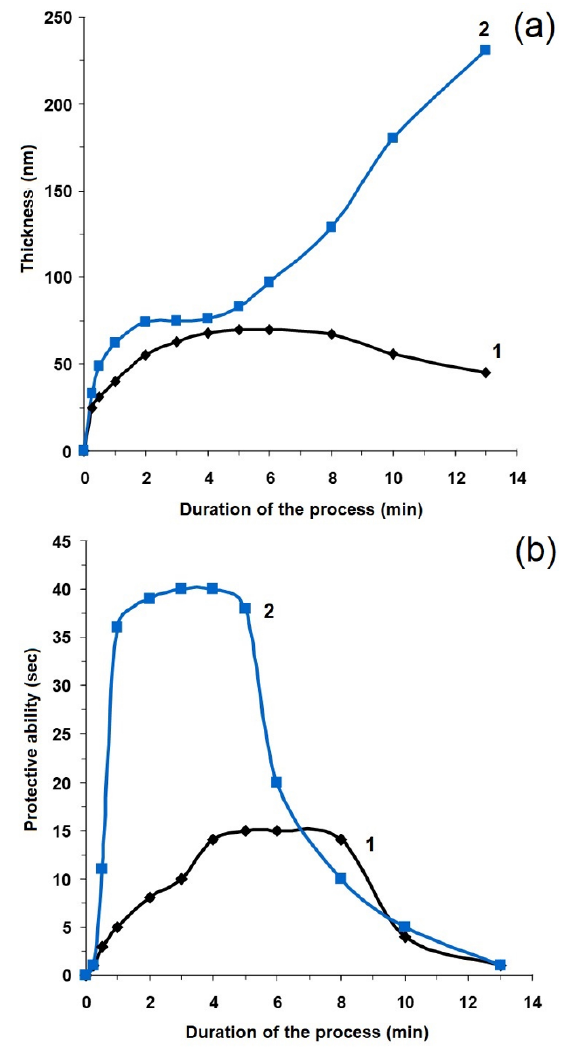
Figure 8. The dependence of the thickness ( a ) and the protective ability ( b ) of coatings on the duration of the process (1. H 2 TiF 6 : 2 g / L; Ni(NO 3 ) 2 : 0.4 g / L; pH 4.6–5.0; T : 20 ◦ C) (2. H 2 TiF 6 : 2 g / L; Ni(NO 3 ) 2 : 0.4 g / L; (NH 4 ) 6 Mo 7 O 24 : 0.3 g / L pH: 4.6–5.0; T : 20 ◦ C).